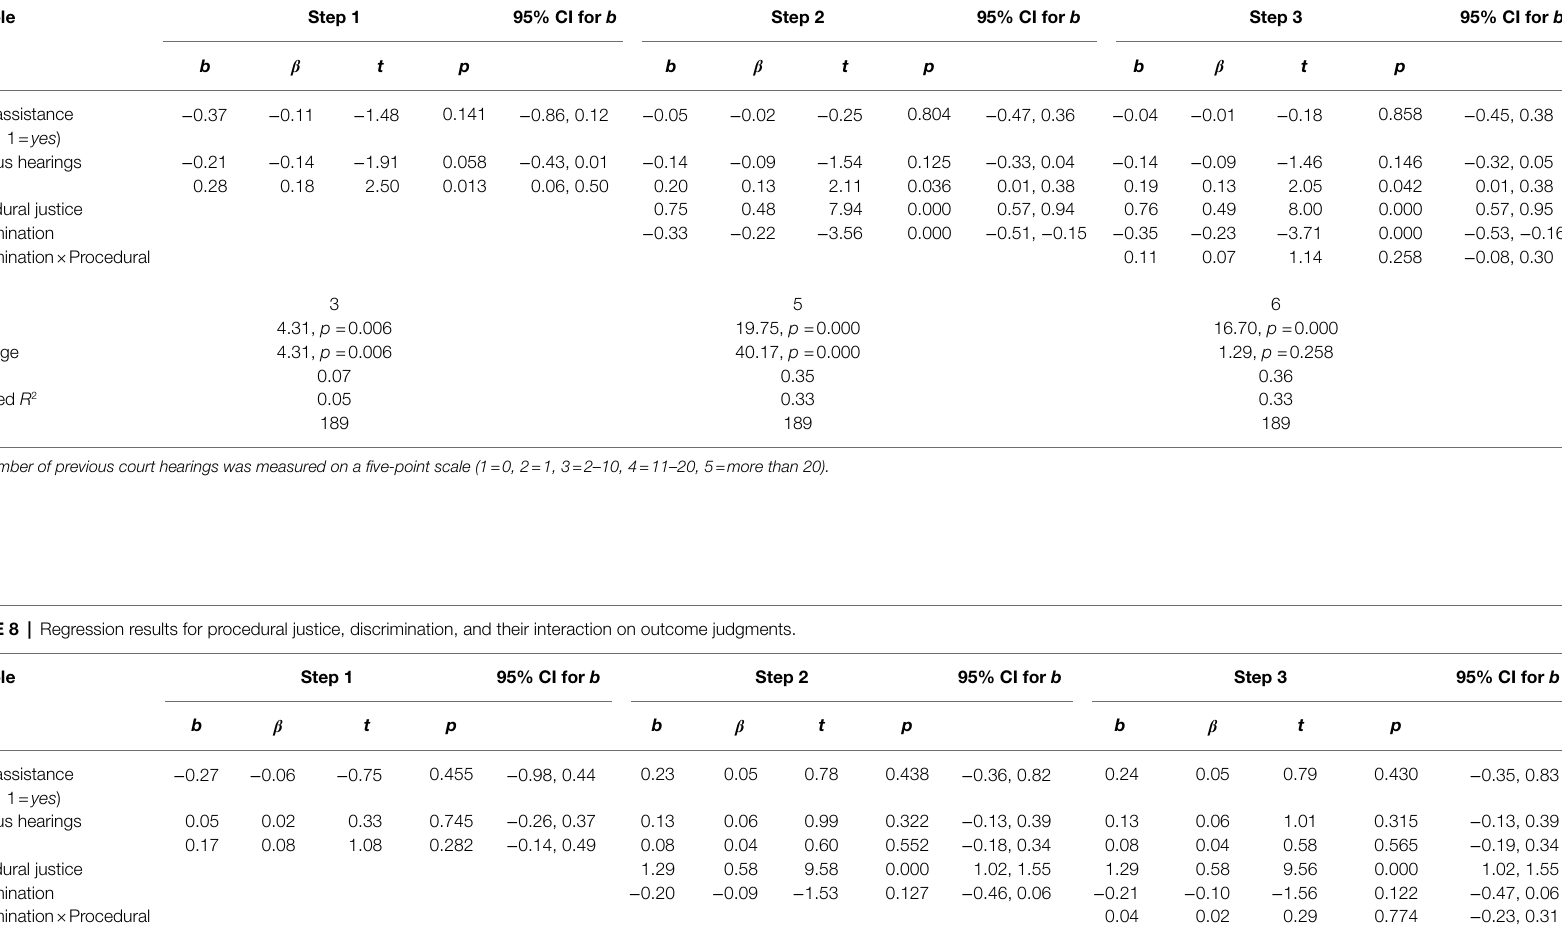
TABLE 7 | Regression results for procedural justice, discrimination, and their interaction on trust in judges. Variable Step